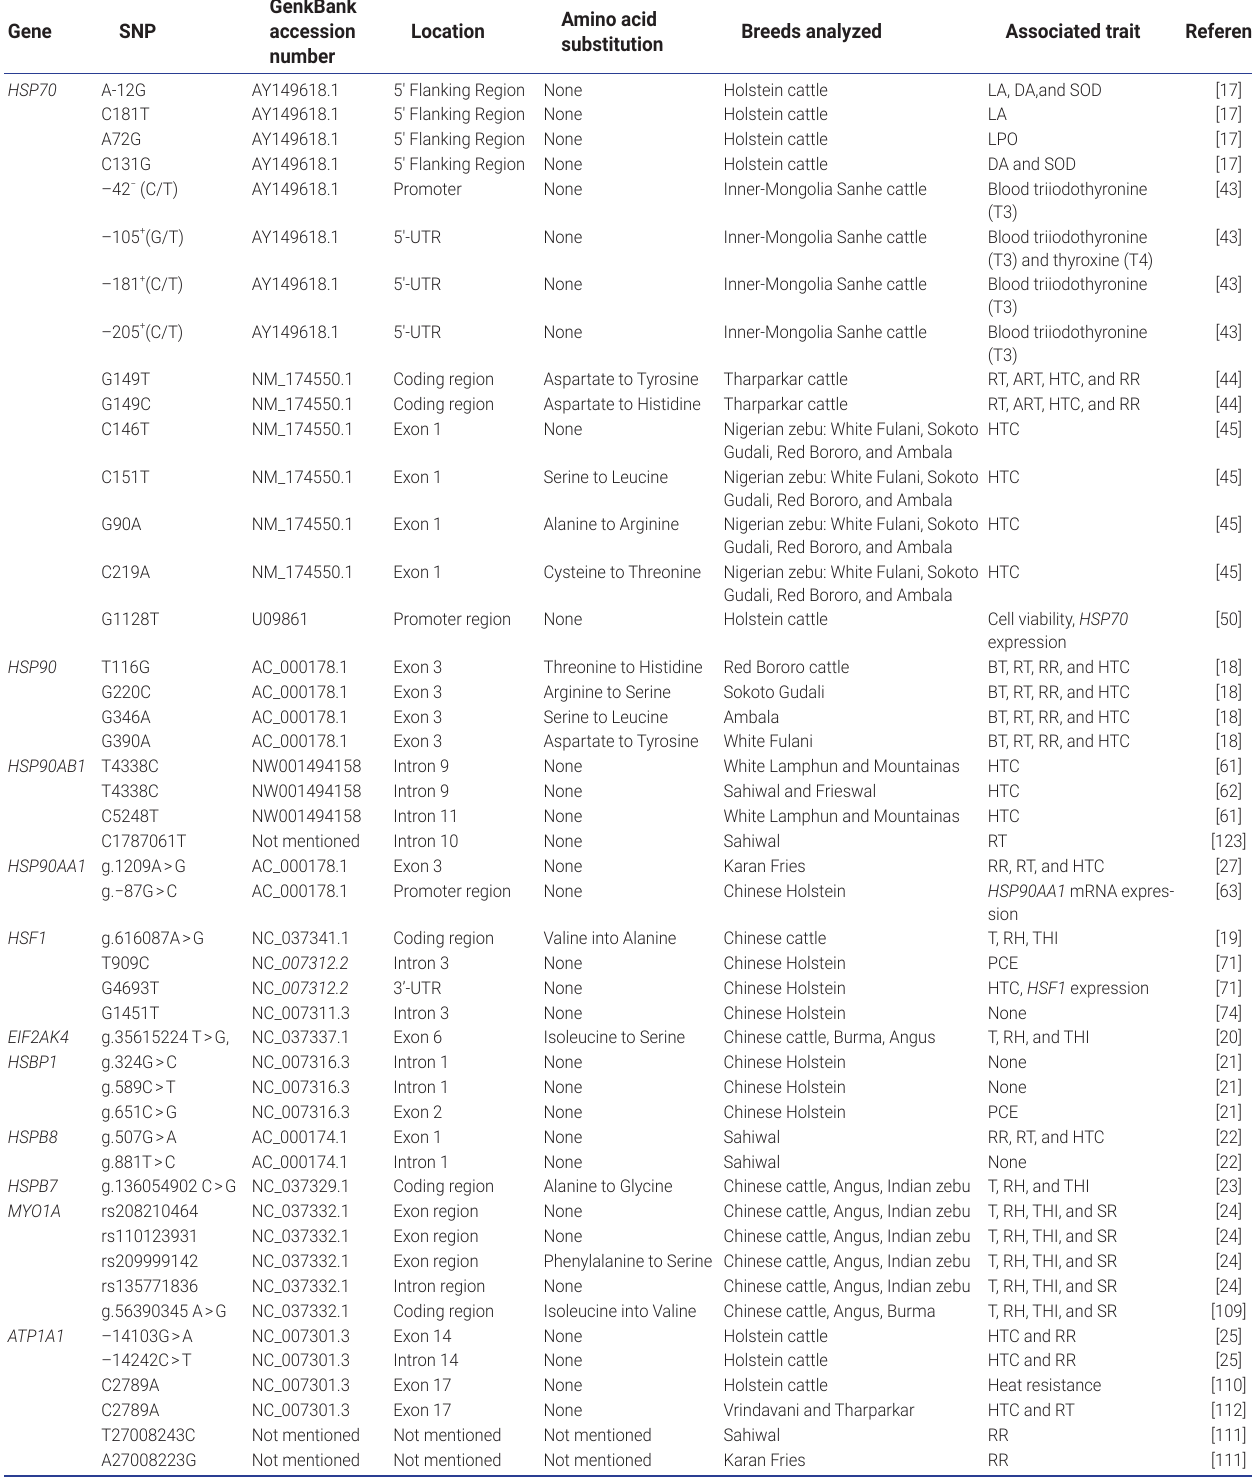
Table 1. Effects of SNPs in some genes on thermotolerance in cattle Gene SNP Breeds analyzed Associated